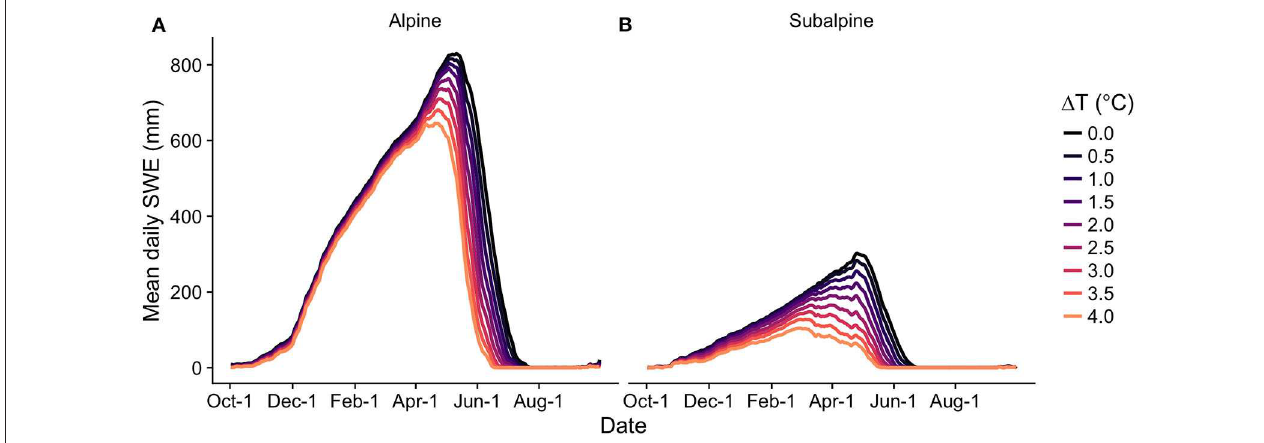
FIGURE 2 | Mean daily modeled SWE for the baseline and warming simulations in the alpine (A) and subalpine (B) .